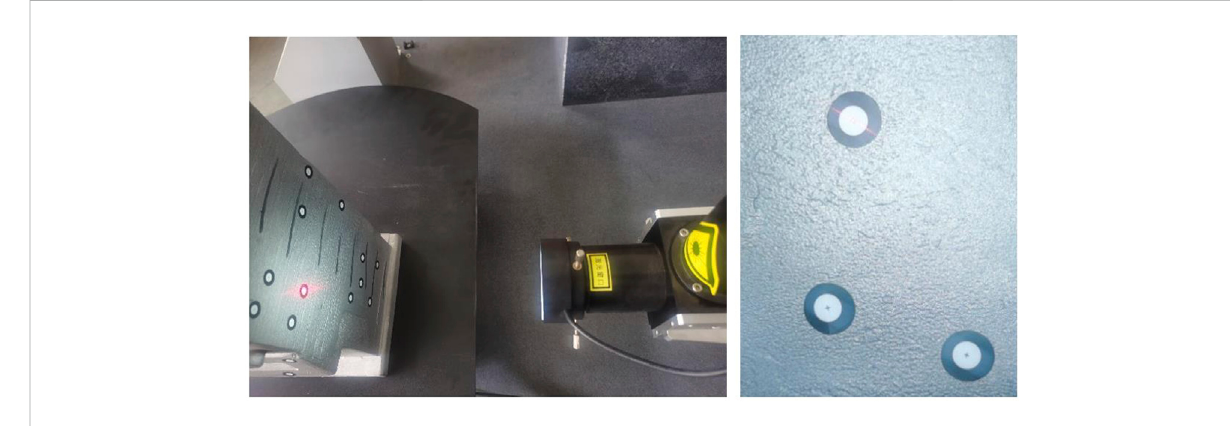
FIGURE 12 The process of experiment.